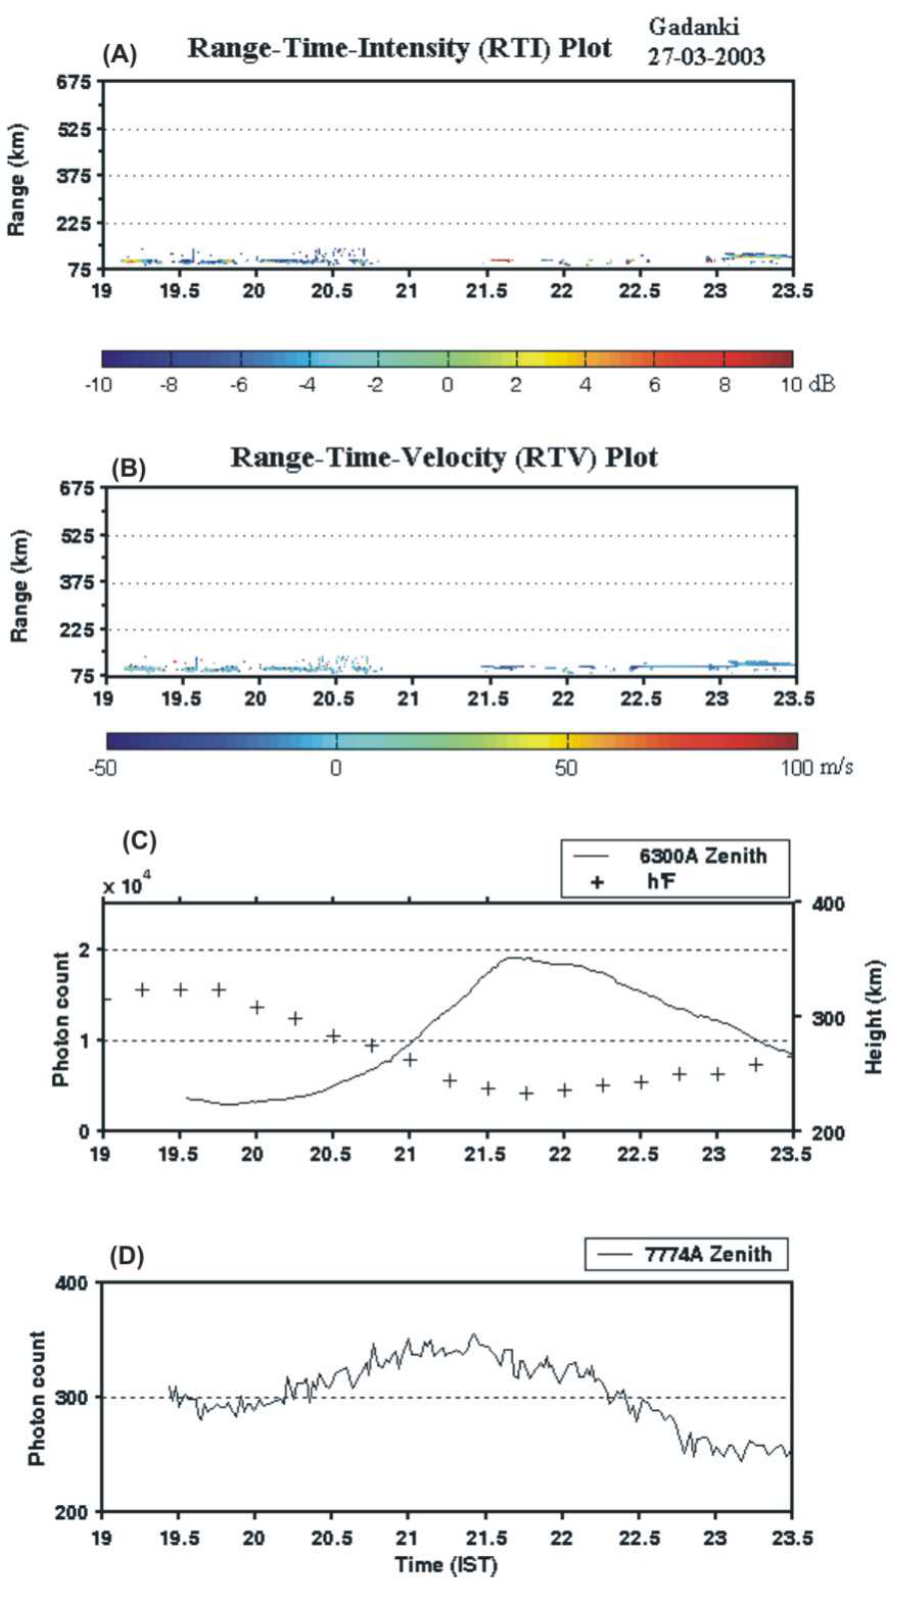
Fig. 2. Similar to Fig. 1 showing the absence of micro variations in the airglow intensity on a non-ESF night, 27 March